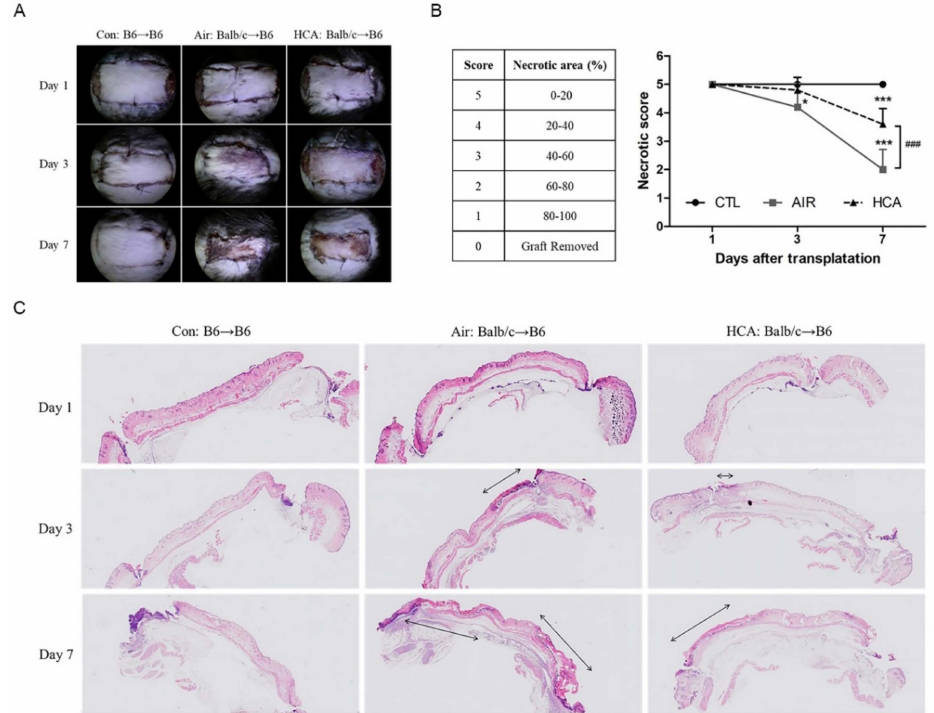
Figure 2. Macroscopic images of skin grafts in mice after transplantation. ( A ) Representative photographs are shown of recipient mice after receiving skin allografts. ( B ) Statistical analysis of the necrotic levels of grafts from day 1 to day 7 post-transplantation. ( C ) Histological appearance of skin grafts shown by a representative micrograph of skin tissue (10 × magnification). The double arrow indicates the area of skin necrosis ( n = 5 mice/day/group). * p < 0.05 and *** p < 0.001 compared with Con group; ### p < 0.001 compared with Air